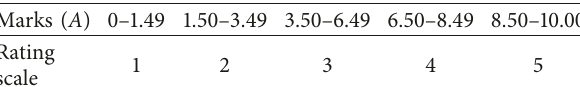
Table 4: Rating scale